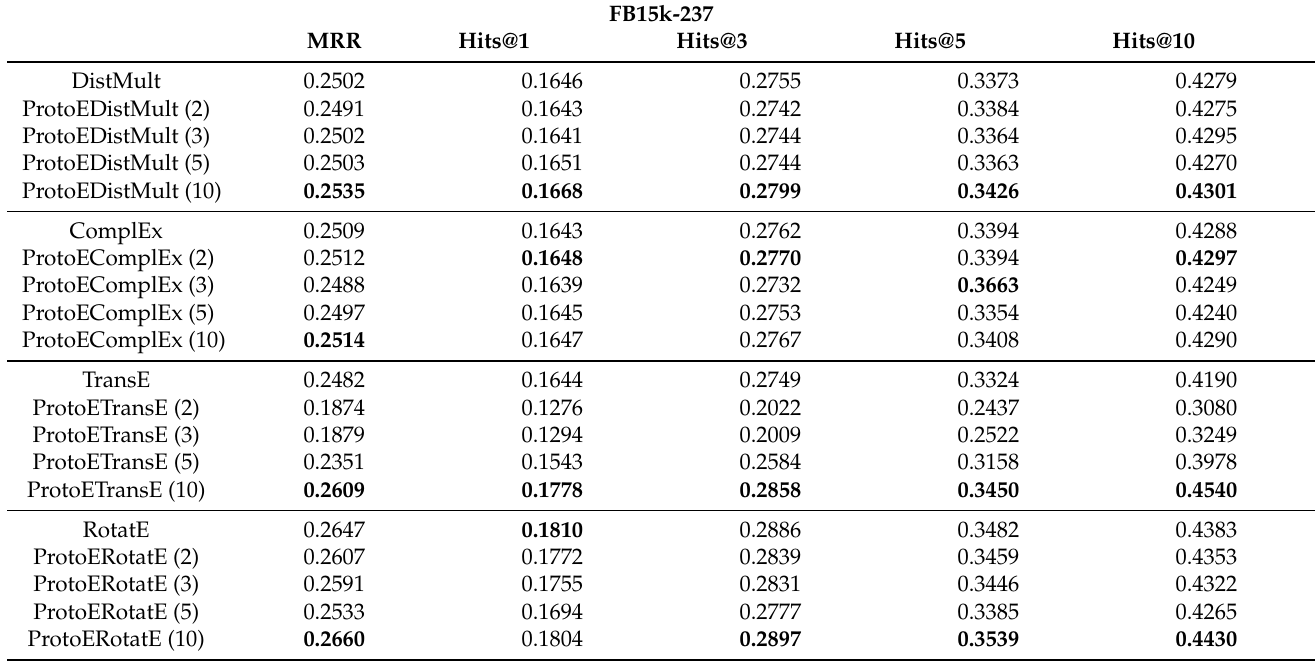
Table 5. Results of ablation experiments for prototype embedding on FB15k-237. Best values are indicated in